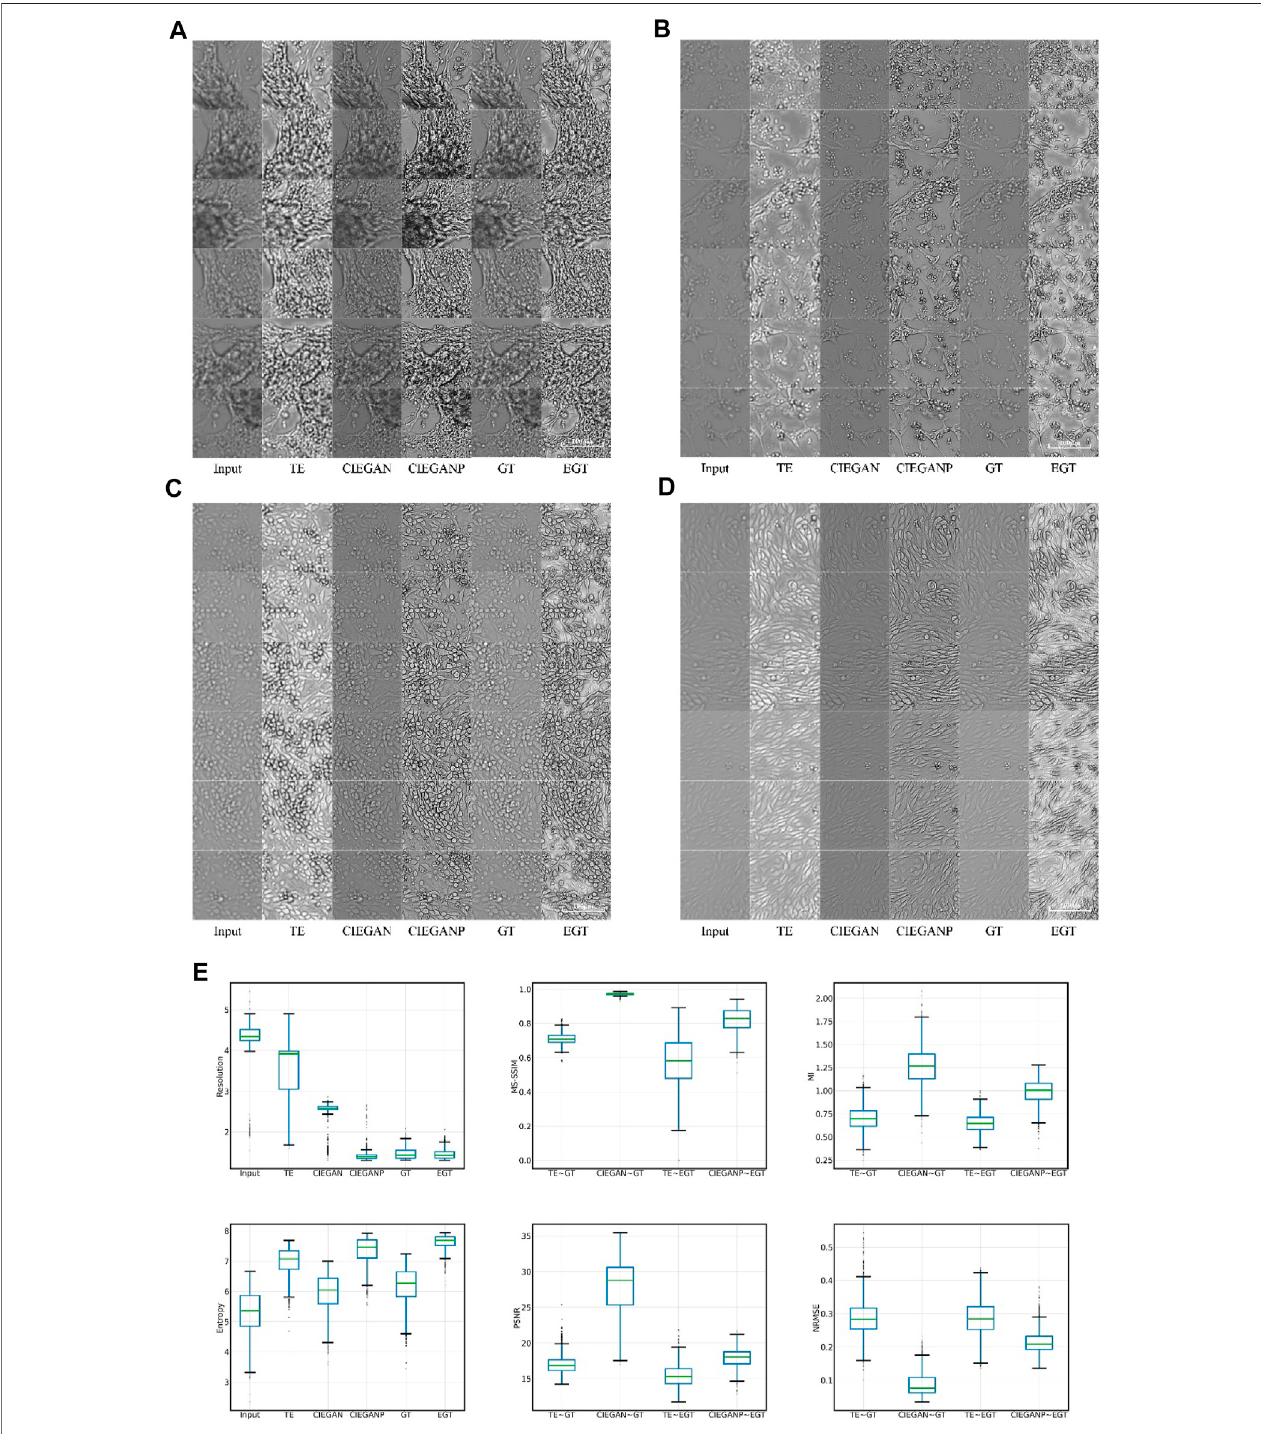
FIGURE 5 | Bright fi eld cell image enhancement results of iPSC-CM differentiation experiments. The results for different cell morphologies are shown in sub fi gures (A) , (B) , (C) , and (D) . TE stands for the traditional enhancement method, CIEGAN, CIEGAN plus (CIEGANP) is our method, GT is the ground truth, and EGT is the enhanced ground truth. (E) Boxplot comparison results of resolution, MS-SSIM, mutual information (MI) entropy, PSNR, and NRMSE ( n = 1128).